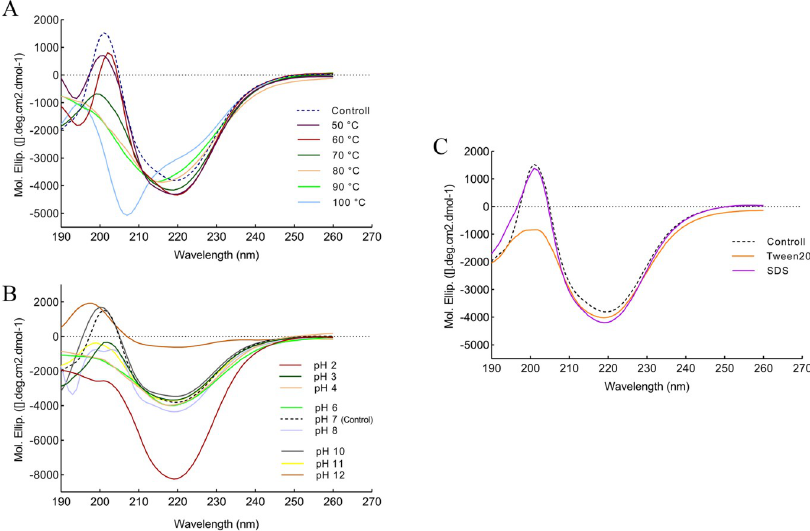
Fig 11. Analaysis of secondary structure changes by far-UV CD. Far-UV CD spectra of protease 1147, (A) at different temperatures, (B) at different pH values, and (C) in the presence of 1% Tween 20 and SDS. These spectra indicated the changes in the secondary structure content of protease 1147. The spectrum of purified protease 1147 at temperature 25˚C and pH of 7 was considered as control.